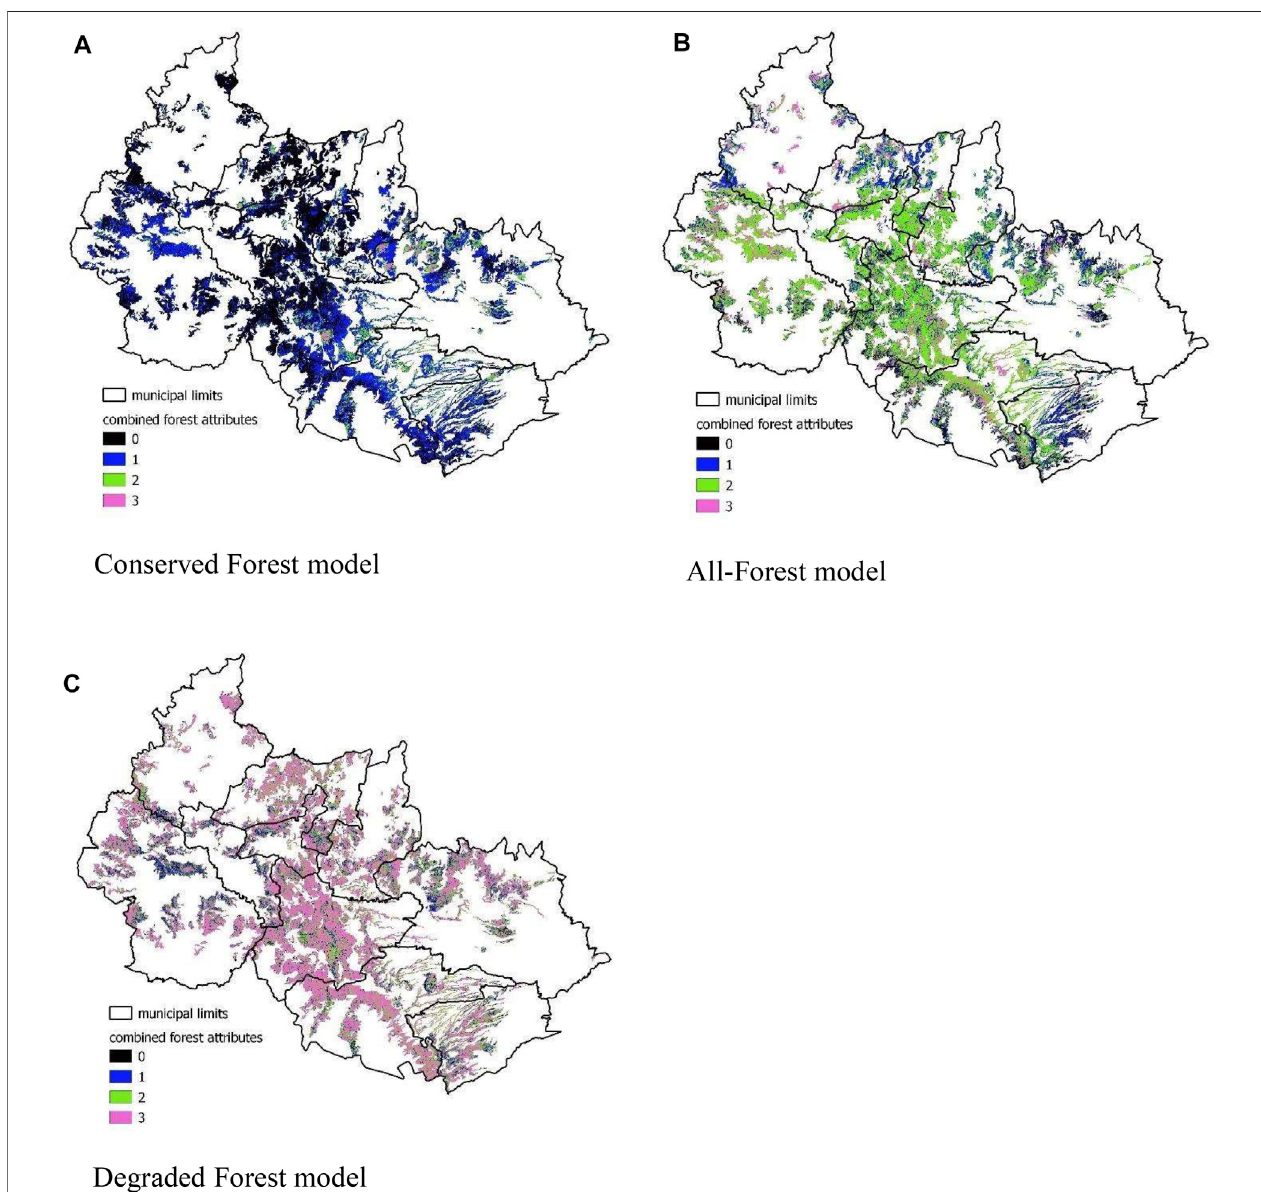
FIGURE4| Mapsindicatingthesumofthenumberofstructuralattributes(canopycover,canopyheightandAGB)belowthedegradedthresholdandproducedby (A) the Conserved Forest model, (B) All-Forest model, and (C) Degraded Forest model, respectively.